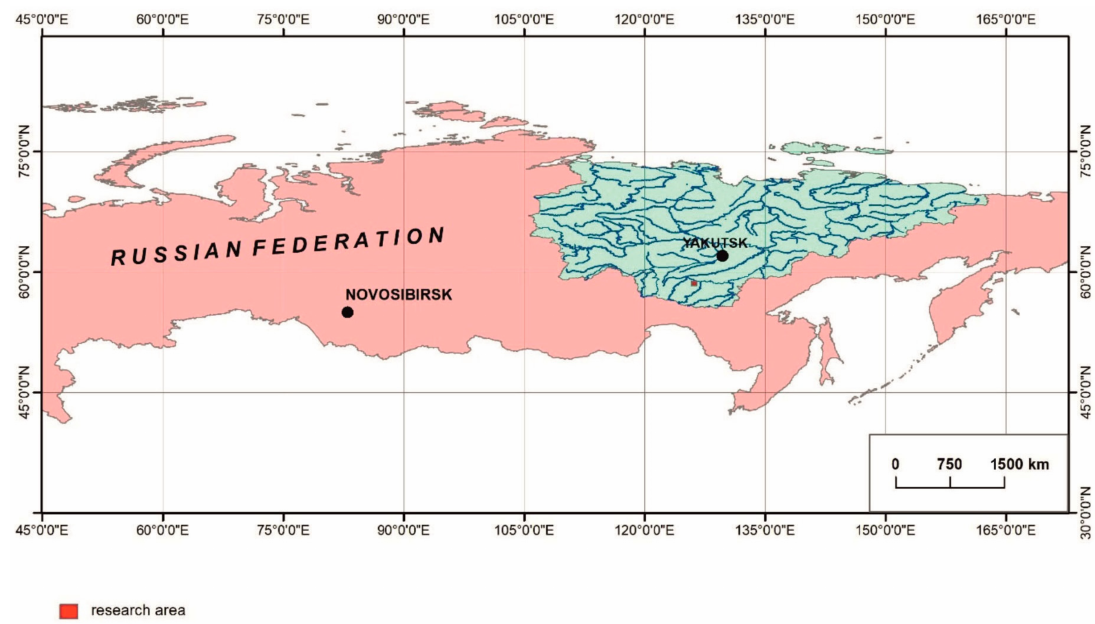
Figure 1. Location of the study